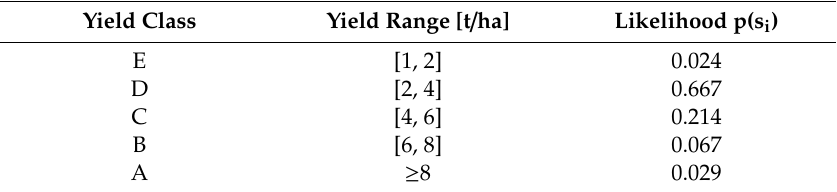
Figure 3. Histogram of olive tree farm yield [t / ha] for selected municipal units of Heraklion, Crete, for the period 2000–2007 [72]. Table 2. Crop yield classes and likelihood of occurrence based on [72].